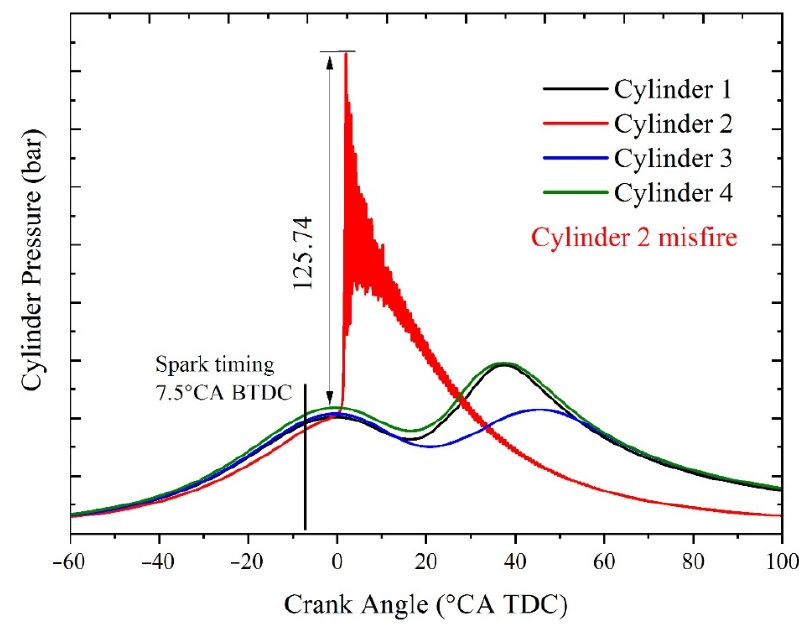
Figure 12. Super ‐ knock in the misfired cylinder. Figure 12. Super-knock in the misfired